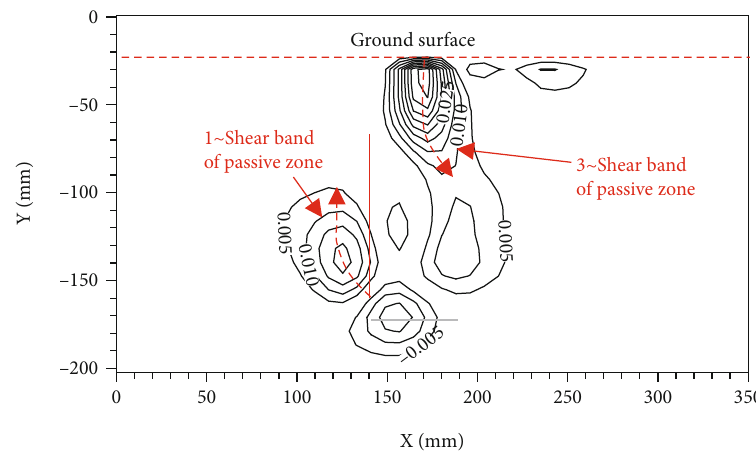
Figure 10: Shear strain fi eld at the ultimate load for D